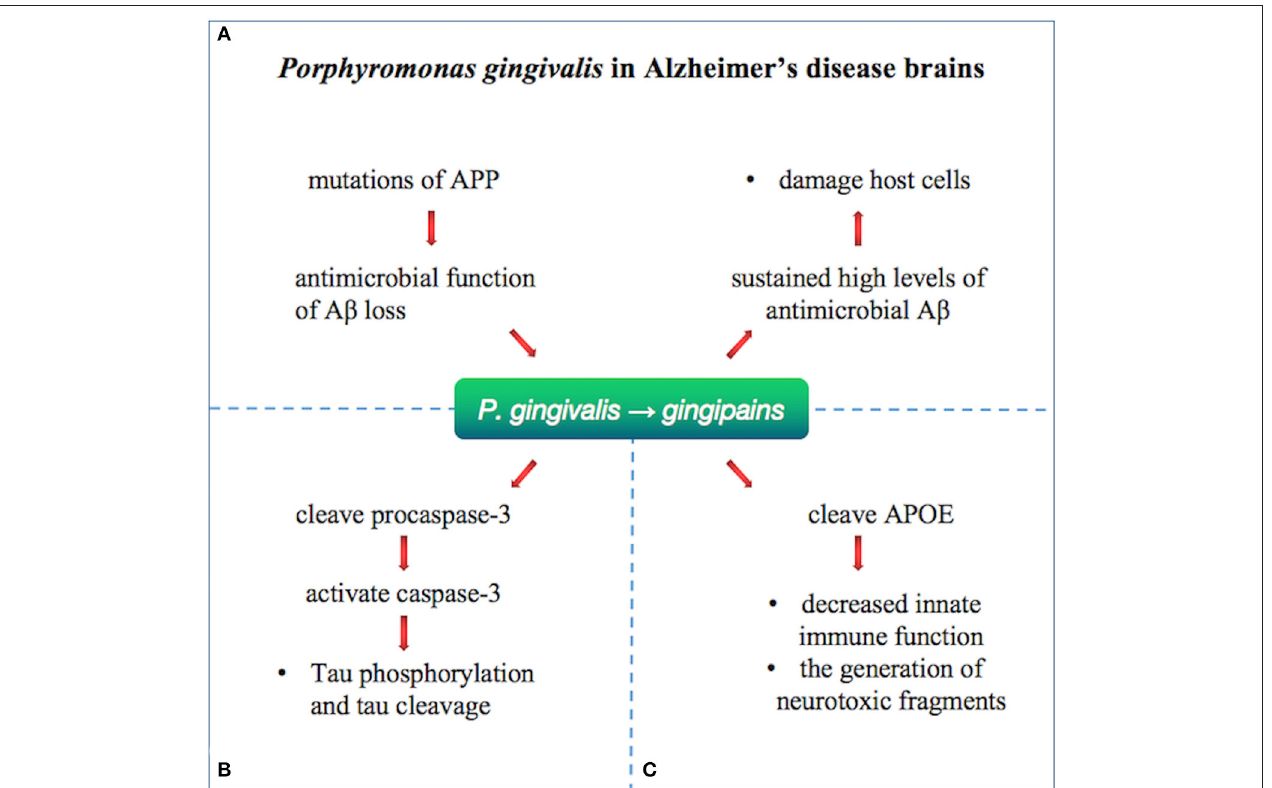
FIGURE 5 | Porphyromonas gingivalis in Alzheimer’s disease brains. Porphyromonas gingivalis were identified in the brain of Alzheimer’s disease patients and relate to A β , tau, and APOE by gingipains. (A) Loss of biological function of A β as an antimicrobial peptide after APP mutation may lead to further infections. The infection with P. gingivalis results in brain infection of mice and induction of A1-42, which is toxic to host cells. (B) Gingipain proteolysis cause direct damage or activation of procaspase-3 (which can be cleaved to activate caspase-3), resulting in Tau phosphorylation and tau cleavage change. (C) APOE4 may be more vulnerable to gingipain cracking, producing neurotoxic APOE fragments and resulting in decreased innate immune function.